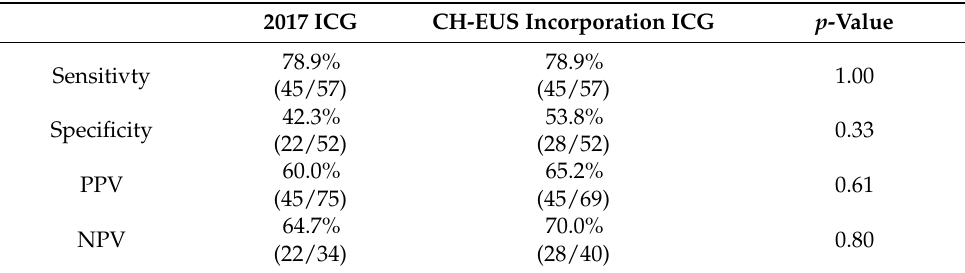
Table 2. A comparison of malignant diagnostic ability between 2017 ICG and CH-EUS incorpora- tion ICG.